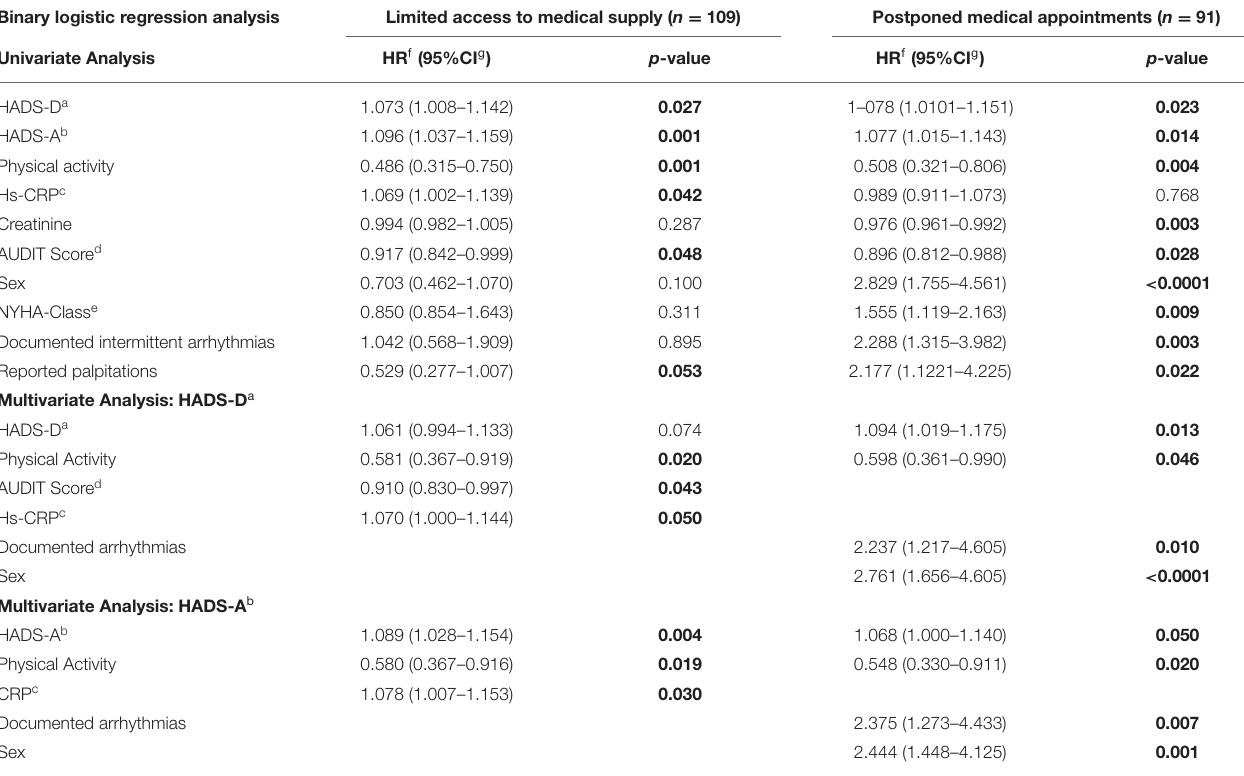
TABLE 4 | Factors that impact access to medical supply and adherence to medical appointments during the COVID-19 pandemic. Binary logistic regression